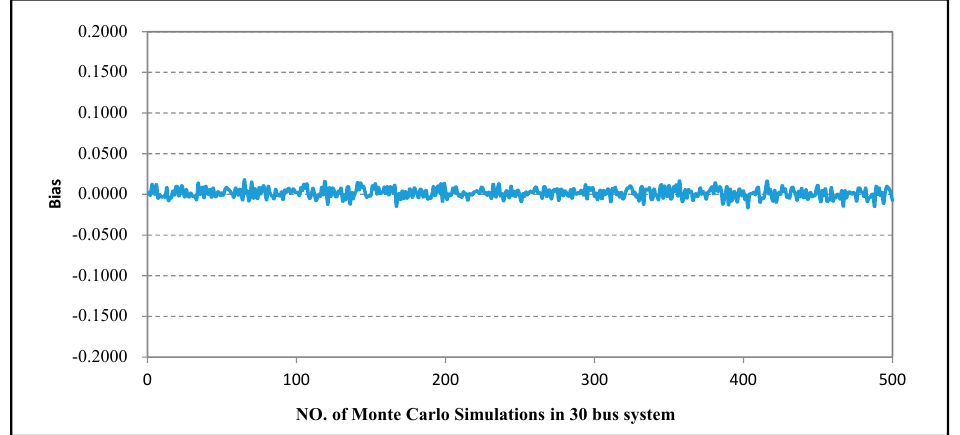
Figure 16. Bias analysis of proposed method in 30 bus system. Figure 15. The percentage of bus voltage angle estimate error in 30 bus system. Table 6. The results of state estimation of four methods in 30 bus system.